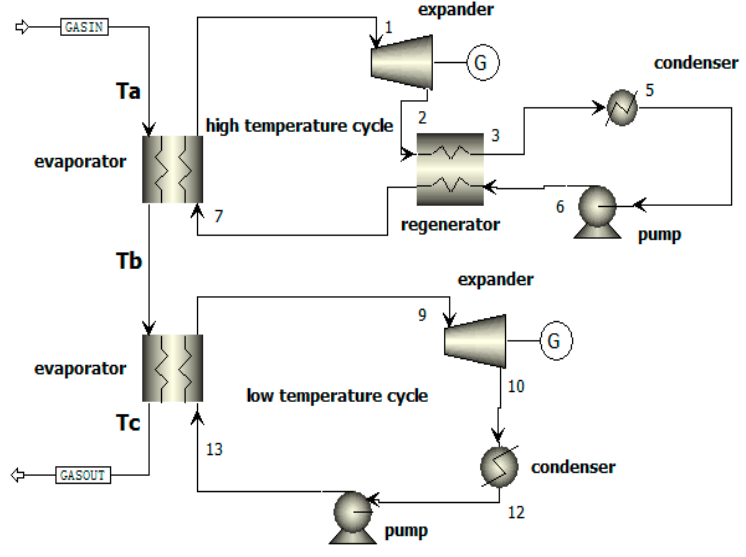
Figure 1. Schematic diagram of the dual loop ORC system.